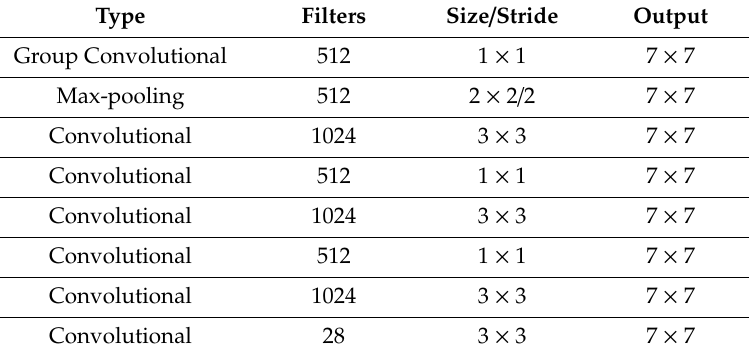
Table 8. Configuration of pass through design for large objects.